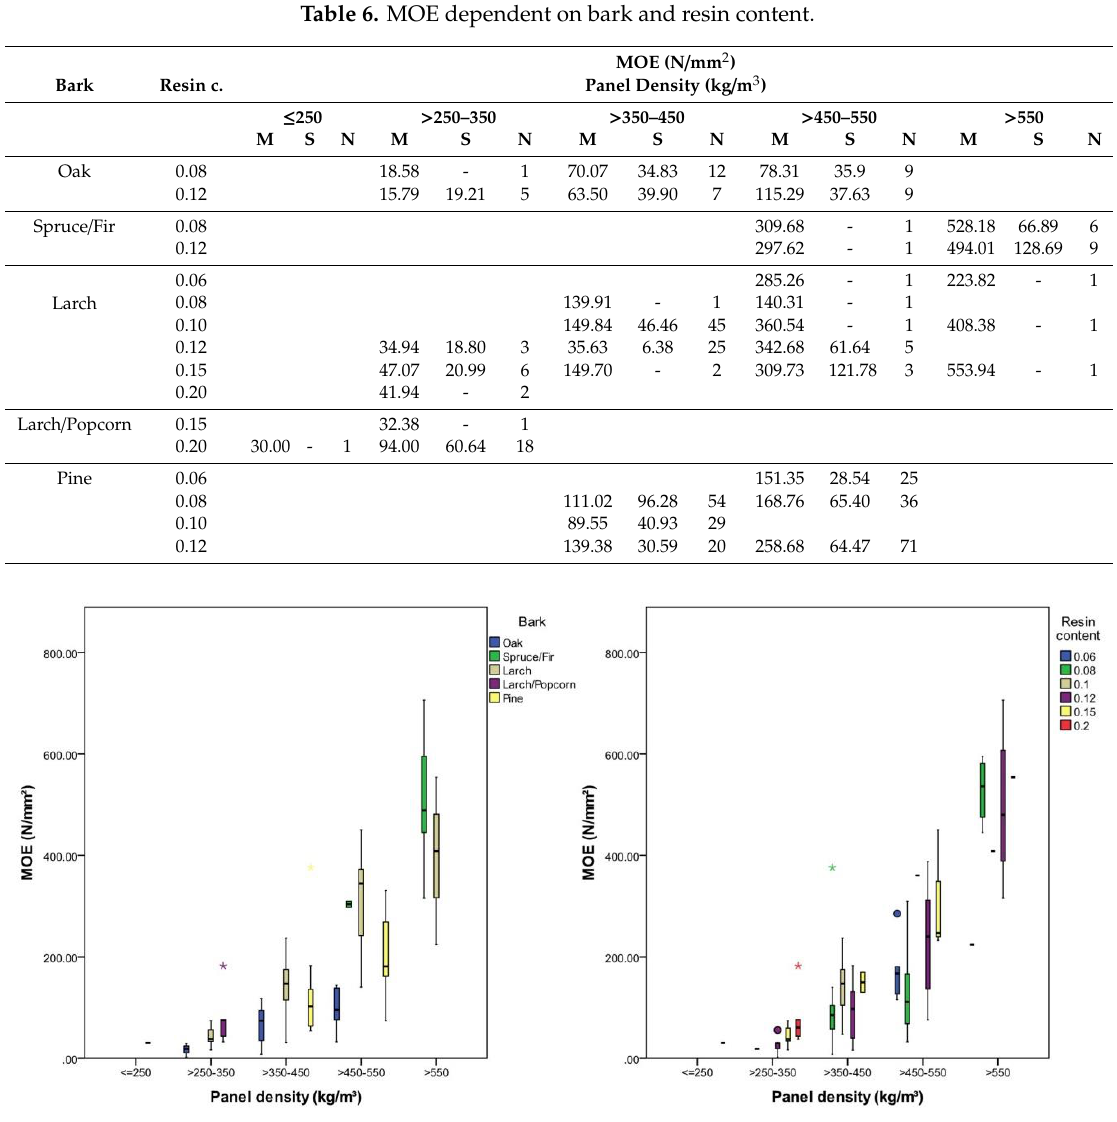
Figure 5. MOE according to panel density, bark type and resin content.